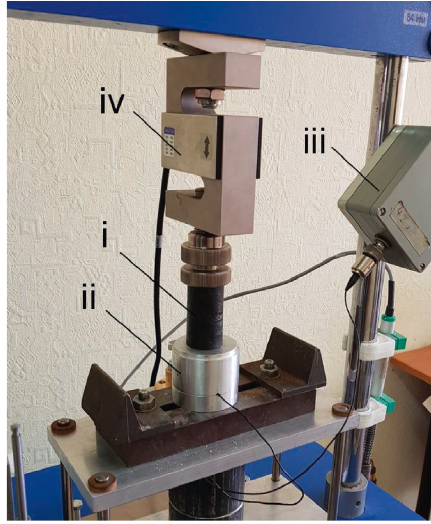
Figure 2: Laboratory setup with the tested sample (i), AE trans- ducer (ii), preamplifier (iii), and stress gauge (iv).